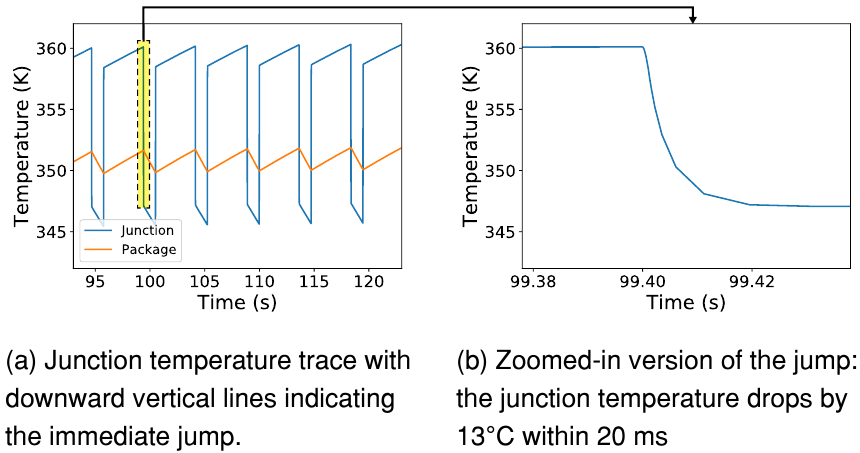
(a) Junction temperature trace with downward vertical lines indicating Figure 3. When disabling NSP, a rapid drop in junction temperature occurs within 20 ms, due to junction time